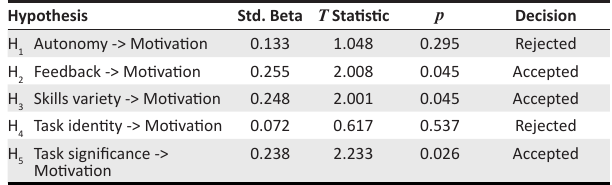
TABLE 2 : Fornell-Larcker criterion. Constructs Autonomy Feedback Motivation Task